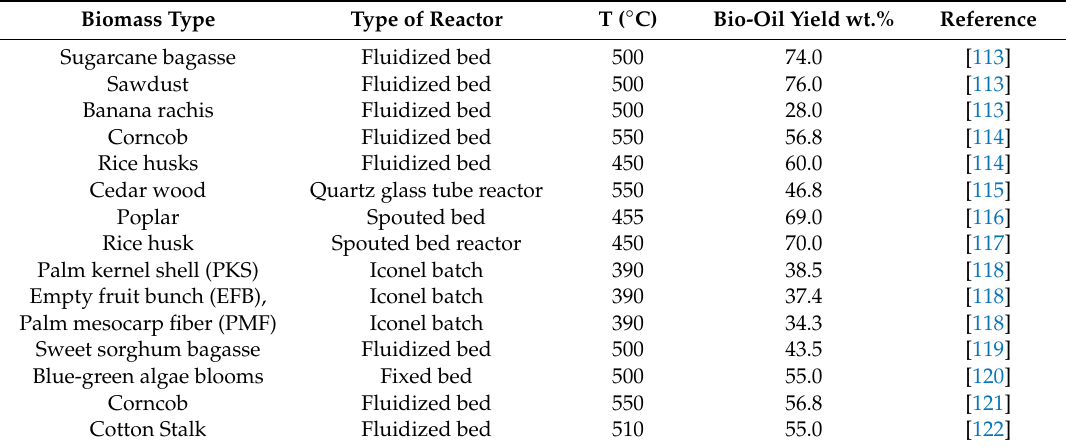
Table 4. Various types of biomass with their respective produced bio-oil yield. Biomass Type